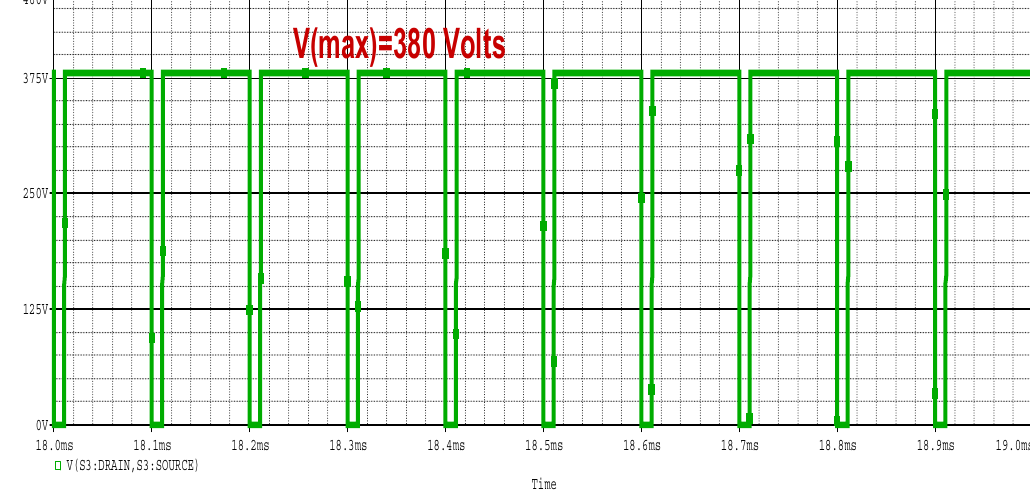
Figure 22. Voltage across S 3 .